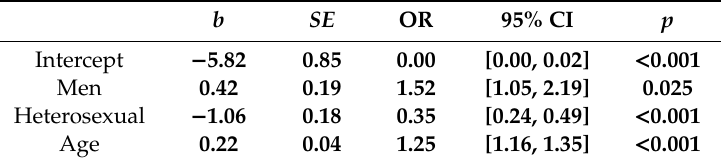
Table 2. Logistic regression analyses of the use of Tinder.